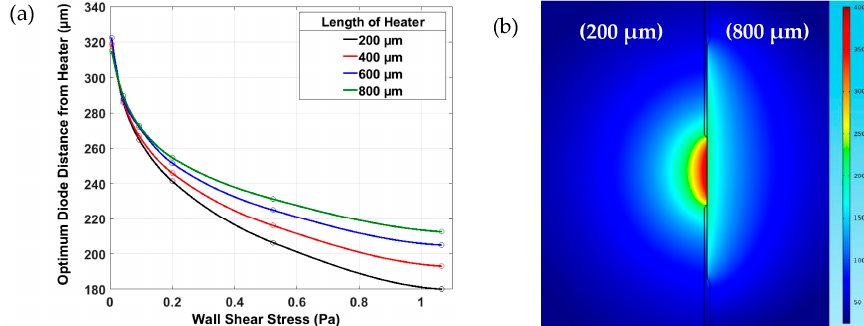
Figure 3. ( a ) Optimum diode distance for varying wall shear stress at 4 different heater lengths and ( b ) showing the difference in heated region shape for heater lengths 200 μ m and 800 μ